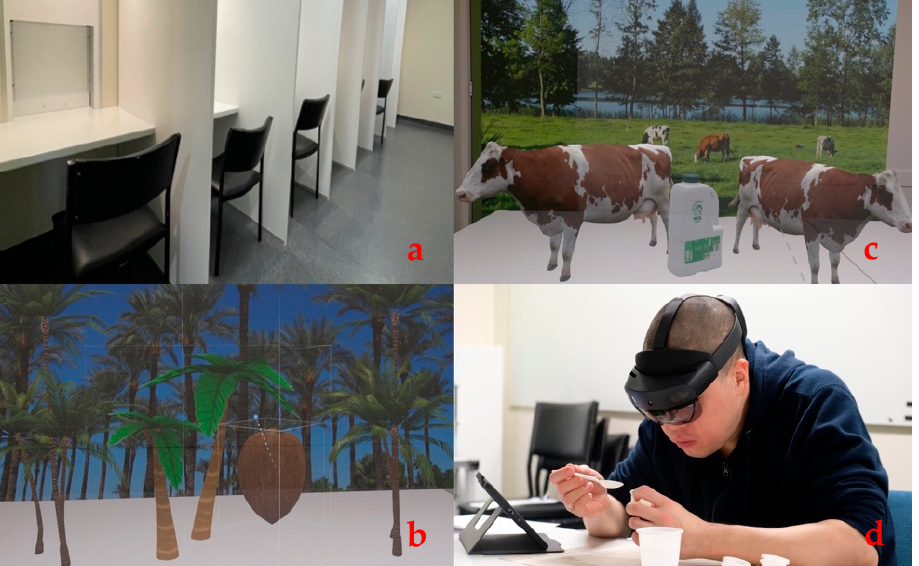
Figure 1. Contextual settings (environments) for sensory evaluation of yogurt samples. ( a ) Sensory booth, ( b ) AR coconut view, ( c ) AR dairy view, ( d ) HoloLens 2 headset.